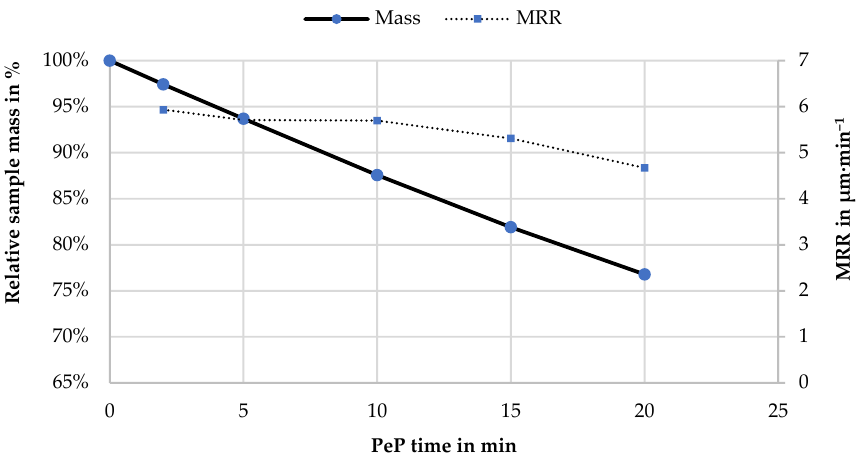
Figure 3. Characterization of the PeP process with increasing processing times by the relative remaining sample mass of sample A6 in percentage and the MRR in µm·min −1 .